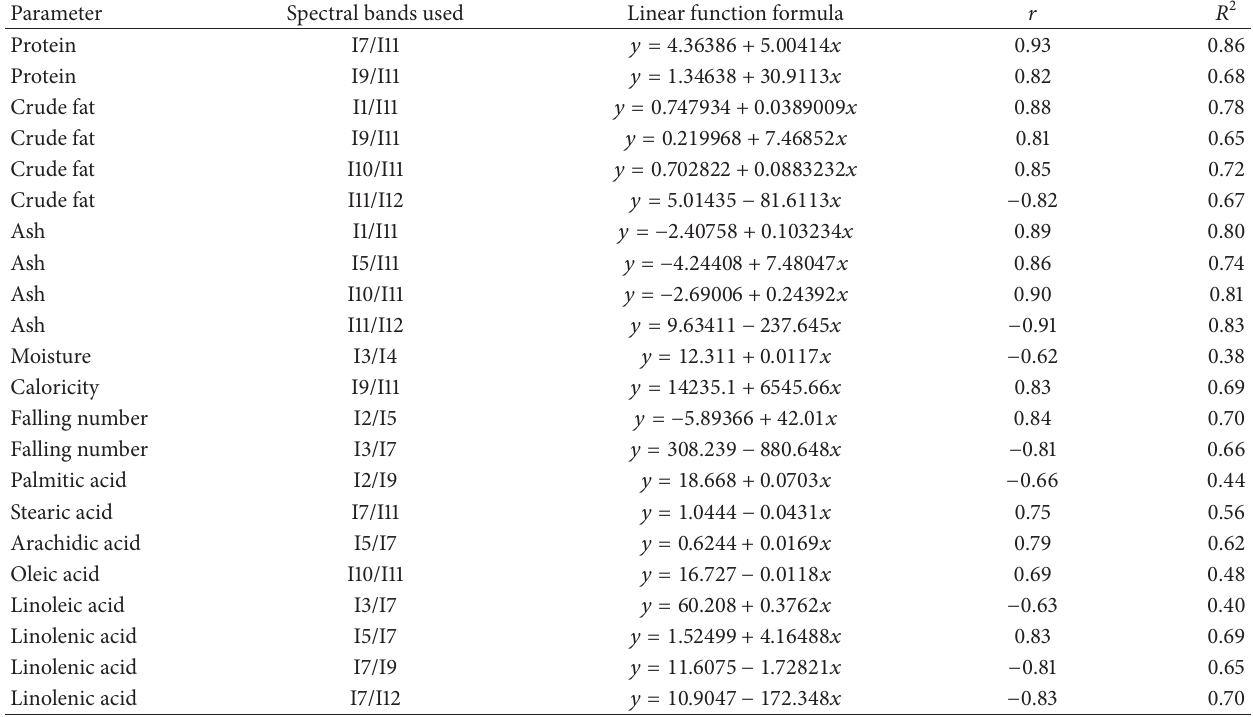
Table 5: Data of CSR correlation analysis.